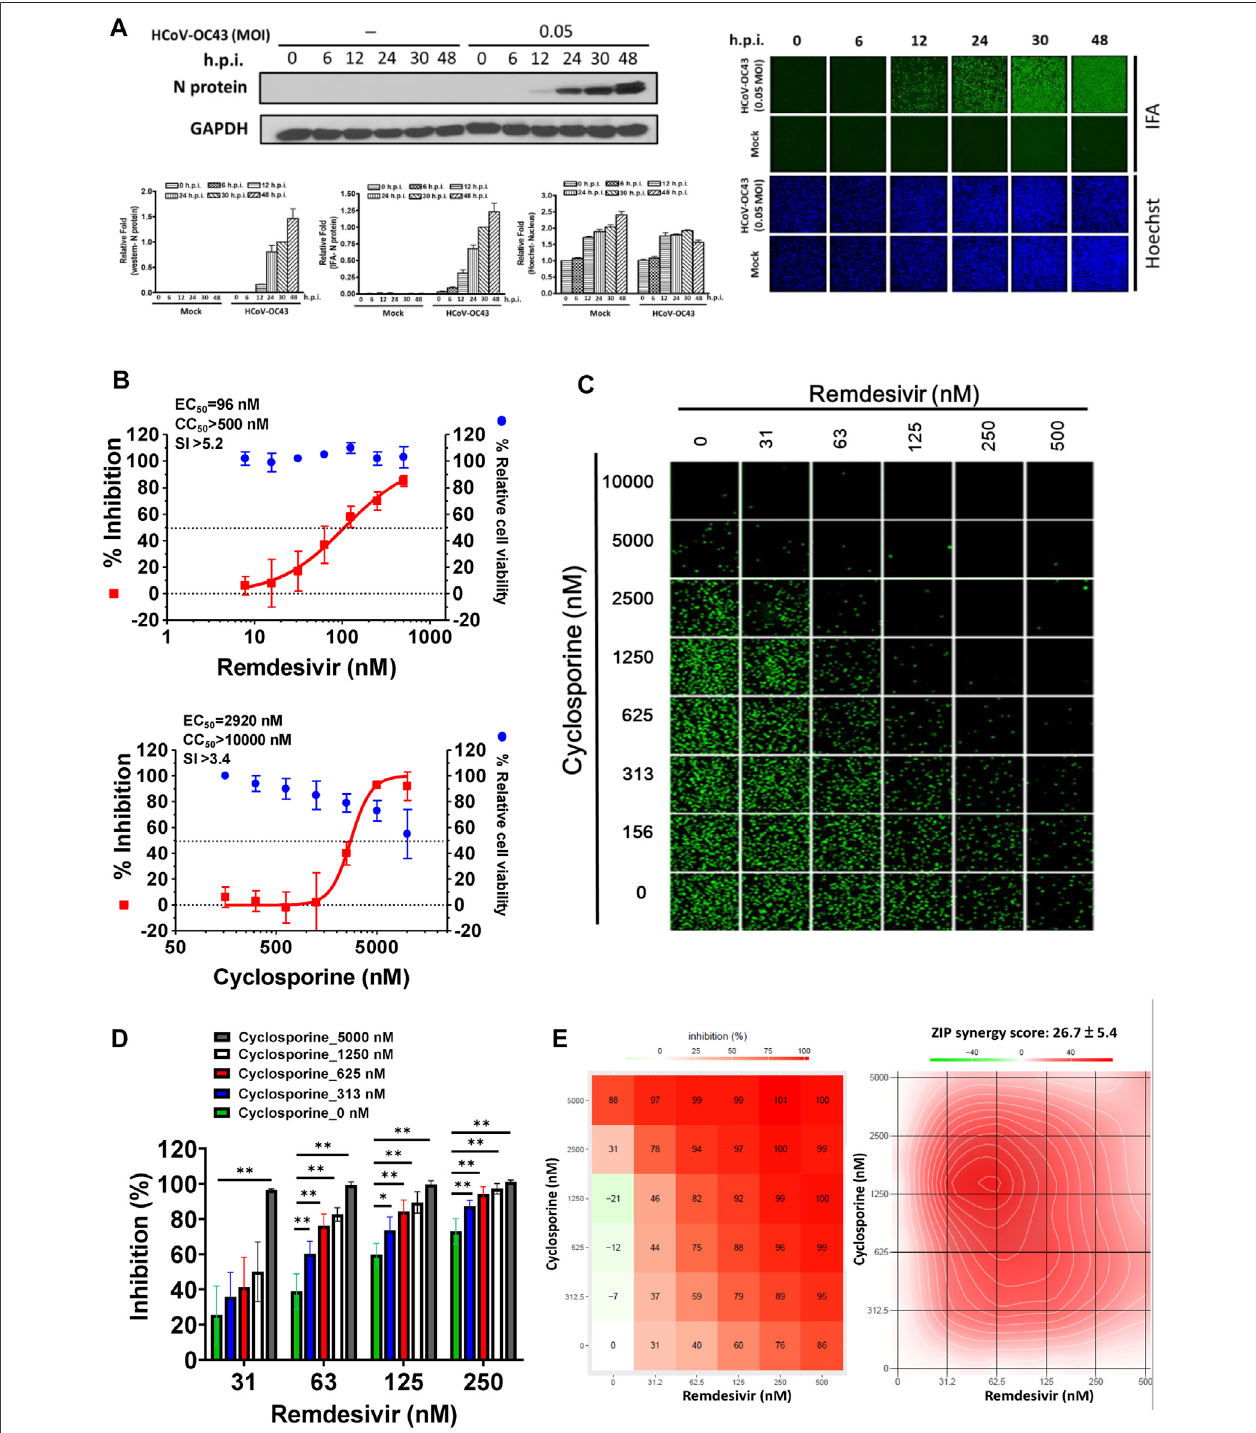
FIGURE 1 | Single or combined treatment of remdesivir and cyclosporine profoundly reduced HCoV-OC43 infection as assayed by immuno fl uorescence (IFAs) in human HCT-8 colorectal carcinoma cells. (A) Time course of HCoV-OC43 N protein expression in infected HCT-8 cells. Western analysis and IFA were performed against an antibody against HCoV-OC43 N protein (Mab9013) with the samples at the indicated time points. (B) Single treatments of remdesivir and cyclosporine reducedHCoV-OC43infectioninHCT-8cellsinadosedependentmanner. (C – E) Combinedtreatmentsofremdesivirandcyclosporinesynergisticallyreducedthe HCoV-OC43 infection in HCT-8 cells. IFAs were performed with an antibody against N protein (green) ofHCoV-OC43 in HCoV-OC43(0.05 MOI) infected HCT-8 cells at 30 h.p.i. treated with vehicle (0.5% DMSO) or compounds as indicated. Nuclei (blue) were counter stained with Hoechst dye and used to determine the relative